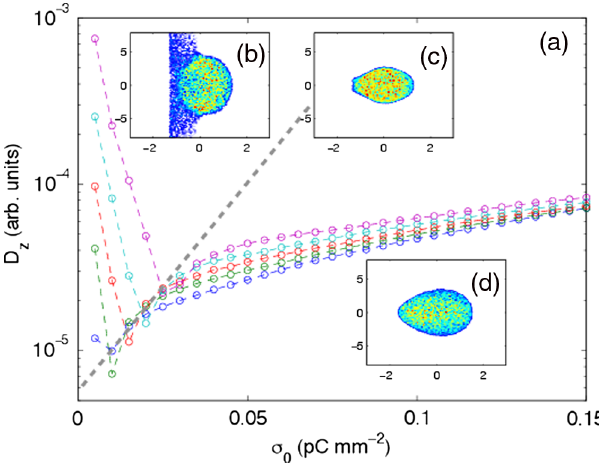
FIG. 7. Computed D z metric [see Eq. (4)] (a) for bunch charges of 100, 250, 500, 1000, and 2000 pC (shown respectively as blue, green, red, cyan, and magenta symbols) as a function of cathode surface density (cid:2) 0 . The gray line indicates loci of minimum D z and the insets (b), (c), and (d) show typical spatiotemporal distributions simulated for the three regimes delineated by the gray line; see text for details. The simulation results are evaluated at the location of X3 in Fig. 2. The insets plot horizontal (respectively vertical) axes corresponding to z (respectively y ) both in units of mm.